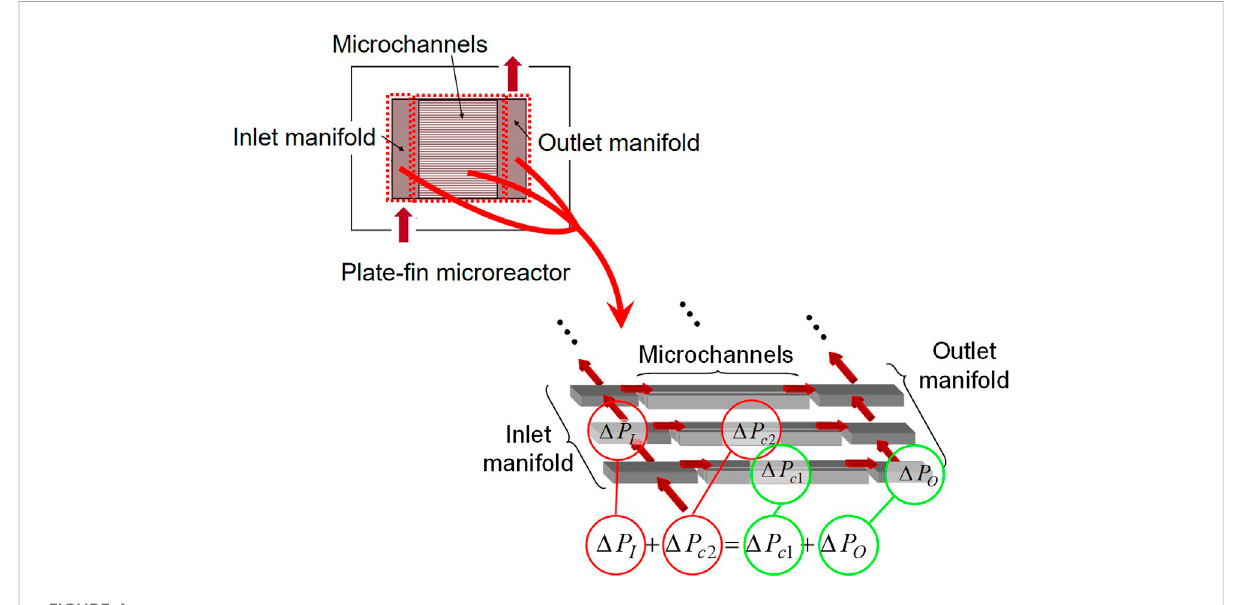
FIGURE 4 Fluid compartment